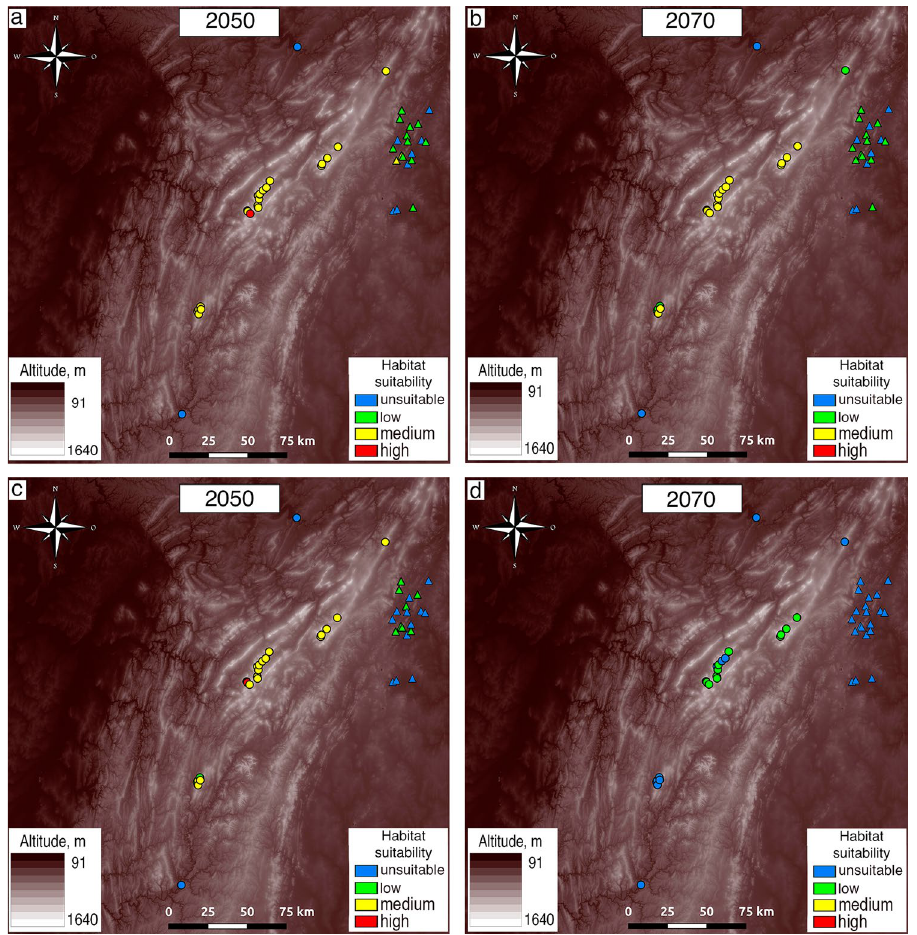
Figure 3. Predictions of the habitat suitability of the locations of Patrinia sibirica in the Southern Urals by 2050 and 2070 under the moderate (RCP4.5) ( a , b ) and the extreme (RCP8.5) ( c , d ) climate change scenarios. Mountain forest locations are marked with circles, mountain forest-steppe locations are marked with triangles. The maps were created using QGIS (v.3.14; www. qgis. org) and GIMP (v.2.10.24; www. gimp.